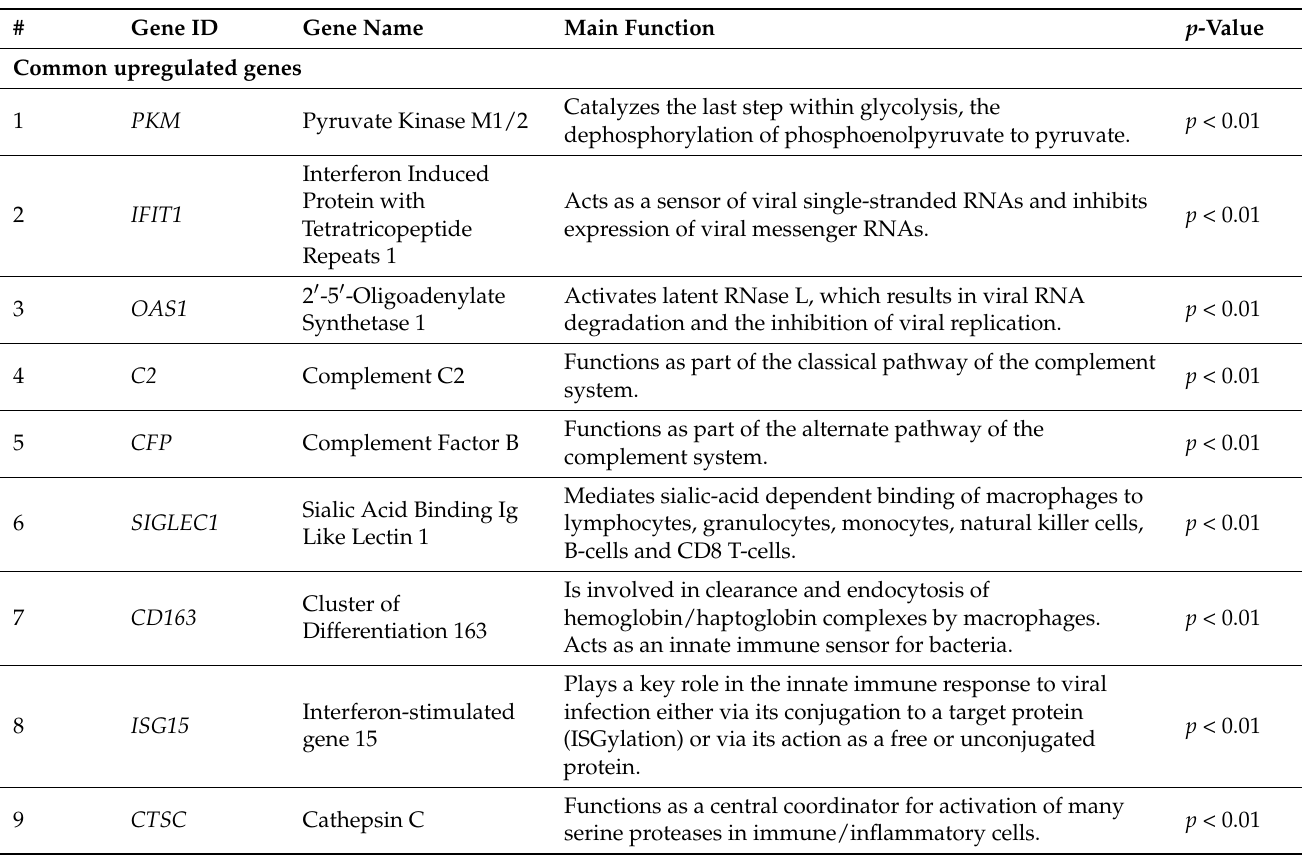
Table 3. Common deregulated genes from nCounter and total RNA-Seq